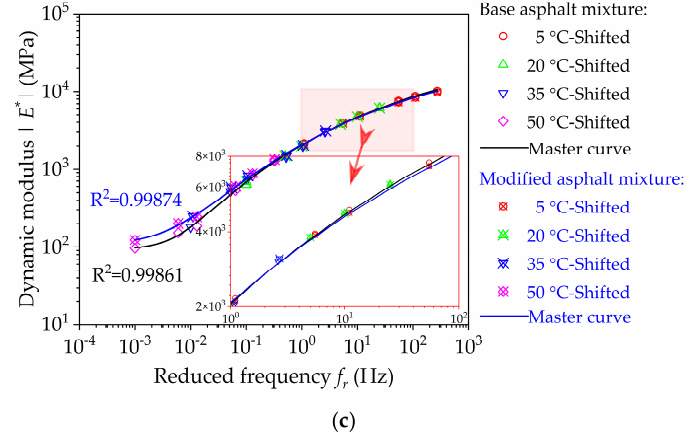
Figure 13. Master curve results of dynamic modulus (reference temperature = 20 °C): ( a ) base bituminous mixture; ( b ) nano-TiO 2 /CaCO 3 modified bituminous mixture; and ( c ) comparative results.